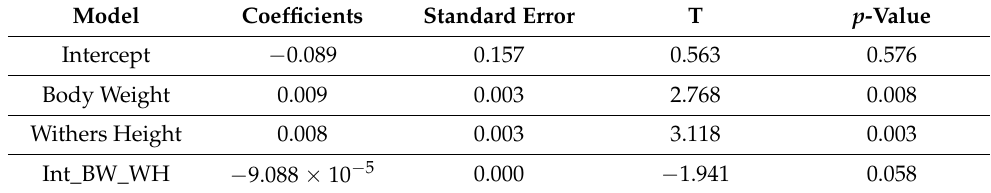
Table 10. Coefficients of stepwise backward regression for the dependent variable pelvic